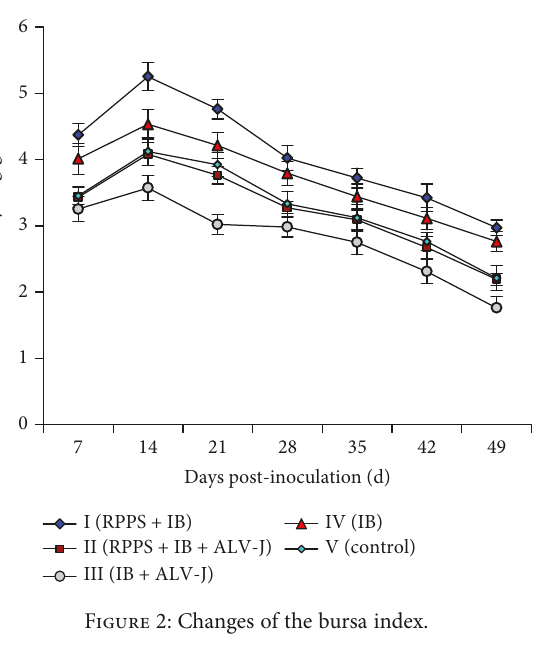
Figure 4: Changes of the spleen index.